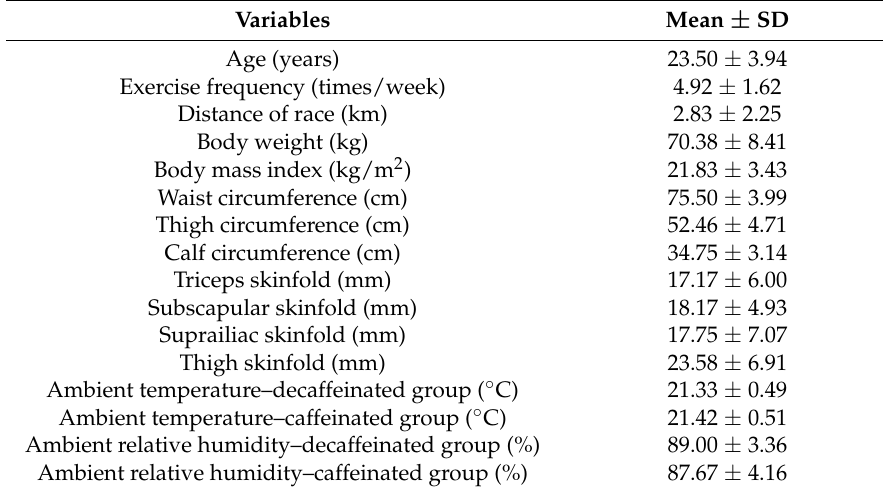
Table 1. General